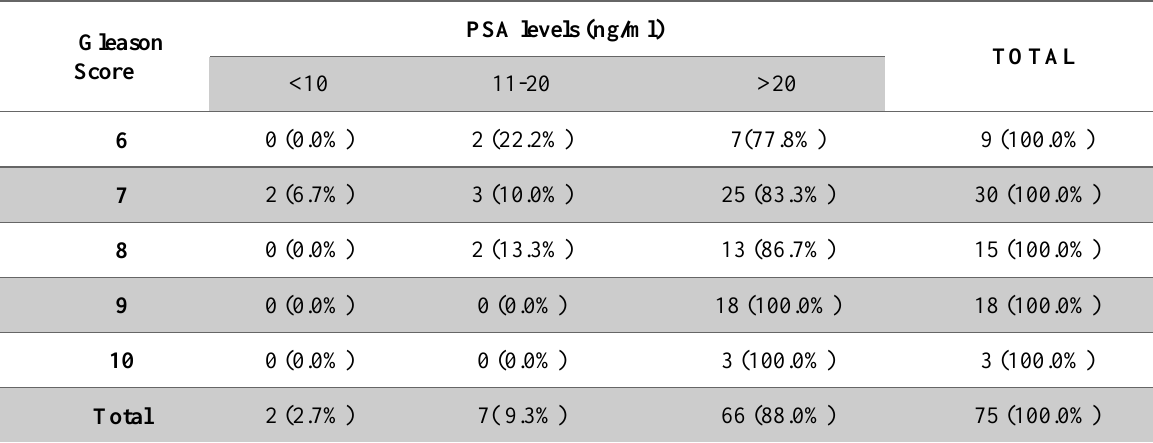
Table 5. Correlation between Gleason Score and serum PSA levels